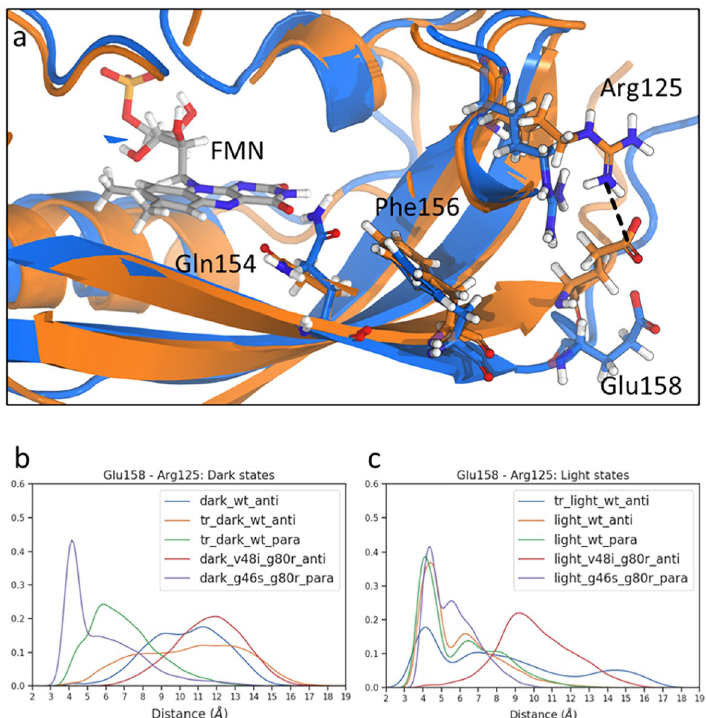
Fig 5. Salt bridge between Glu158 and Arg125. a) Structure of salt bridge between Glu158 and Arg125. Dark state is represented in blue, and light state is represented in orange. Distance measured represented in dashed line. b) Distribution of Glu158 and Arg125 distance for ZTL structures in the dark state. c) Distribution of Glu158 and Arg125 distance for ZTL structures in the light